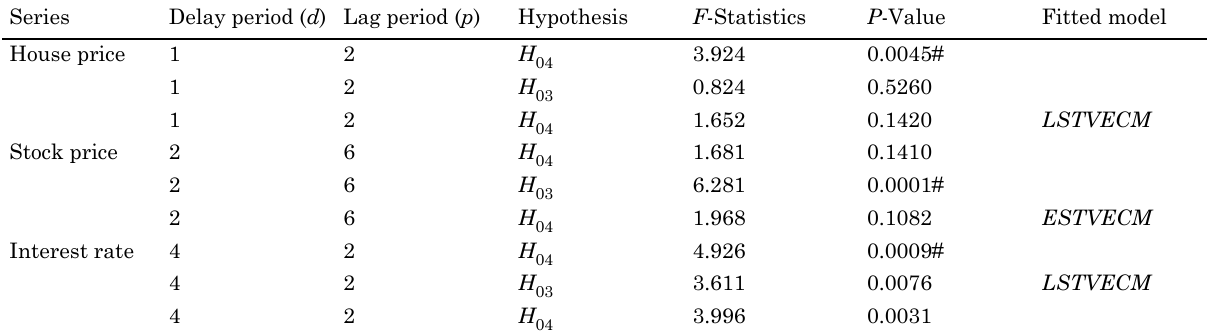
Table 7. Model section for STAR